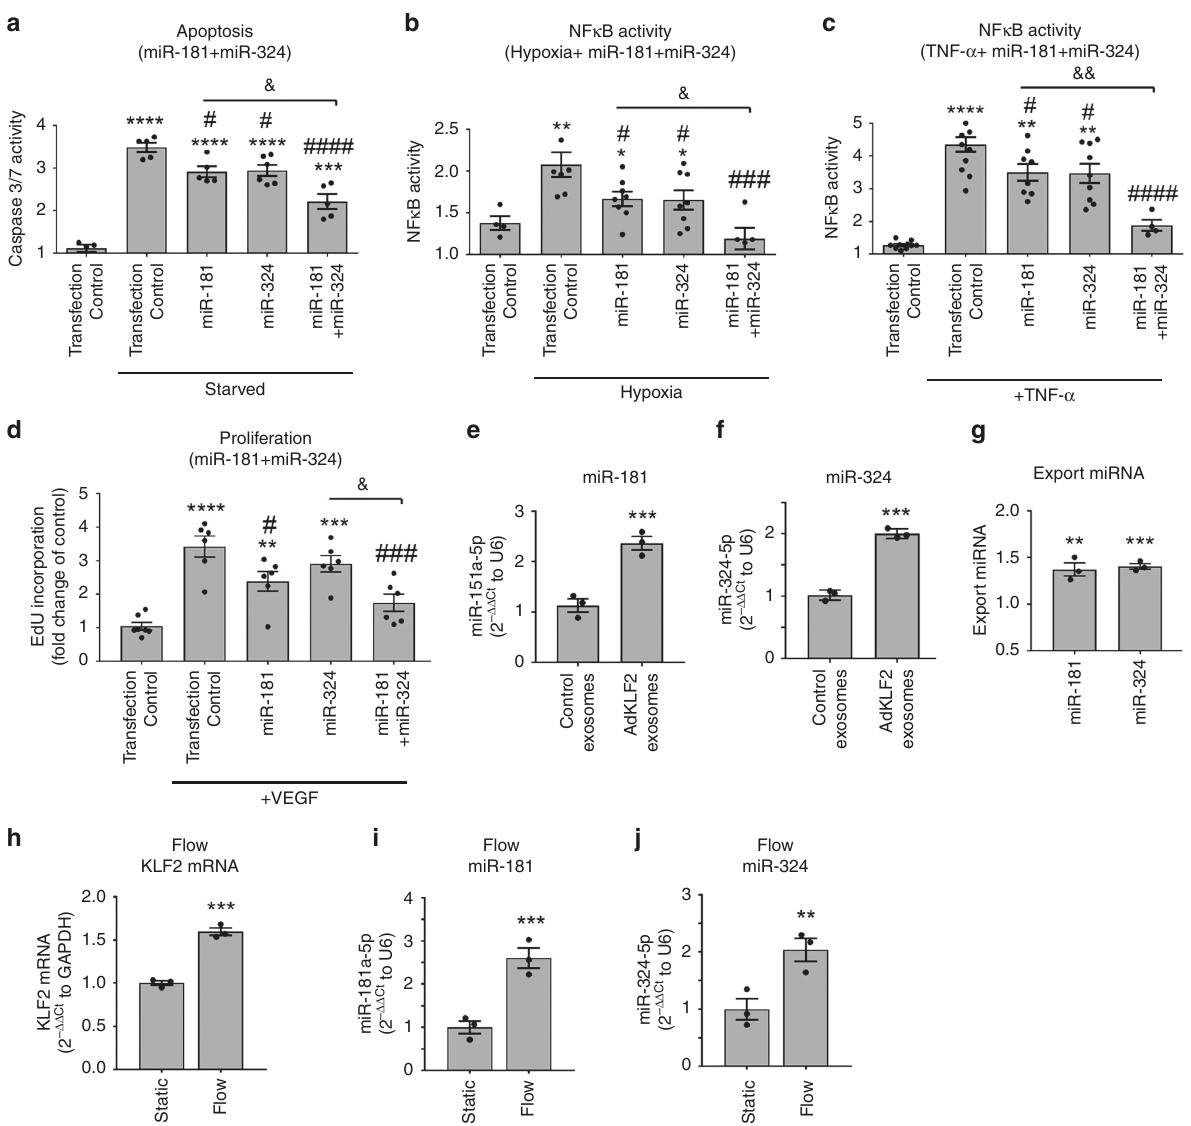
and Table S5 in the Online Data Supplement). Heat maps and unsupervised hierarchical clustering are shown in Fig. 5c. Key targets of miR-181a-5p associated with in fl ammation, cell proliferation and vascular remodelling included α -SMA, TNF- α , IL-1, Notch4 and MMP10, while targets of miR-324-5p included MAPK, NFATC2 and ETS-1 (Supplementary Table 5). No signi fi cant KEGG pathway associations were found for targets up-regulated by miR-181 and miR-324. KLF2, miR-181 and miR-324 and their target genes in PAH . Blood-derived endothelial colony-forming cells (ECFCs) are often